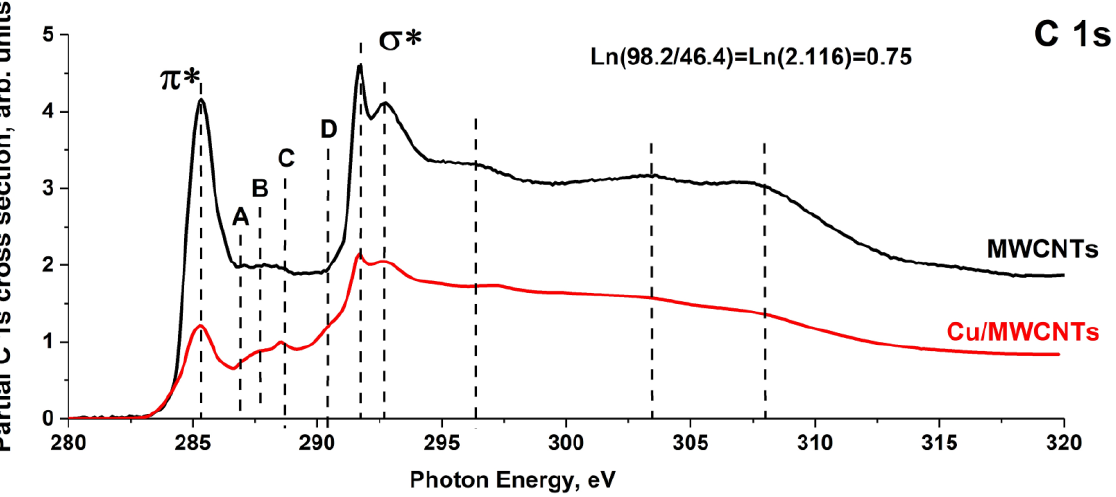
Figure 7. C 1s NEXAFS partial spectra of the initial MWCNTs and the Cu/MWCNTs hybrid nanocomposite.